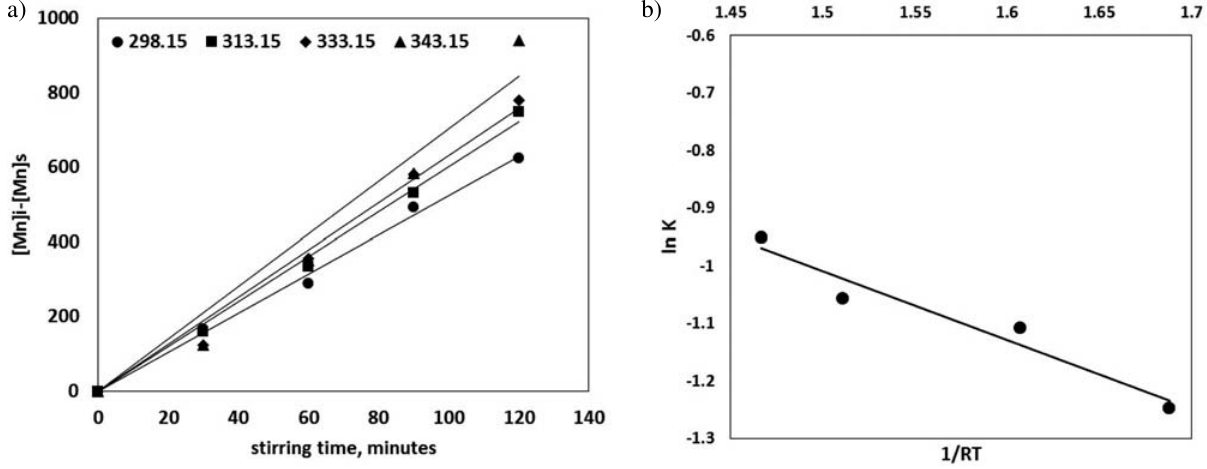
Figure 1. a: Initial manganese (mg/L) minus manganese remaining in solution as a function of stirring time. The slopes are: 5.24, 6.02, 6.33, and 7.04 for 298.15, 313.15, 333.15, and 343.15 K, respectively. b: Estimation of activation energy by means of the Arrhenius equation. Ln K = –1.2*(1/RT) + 0.797 (R2 =